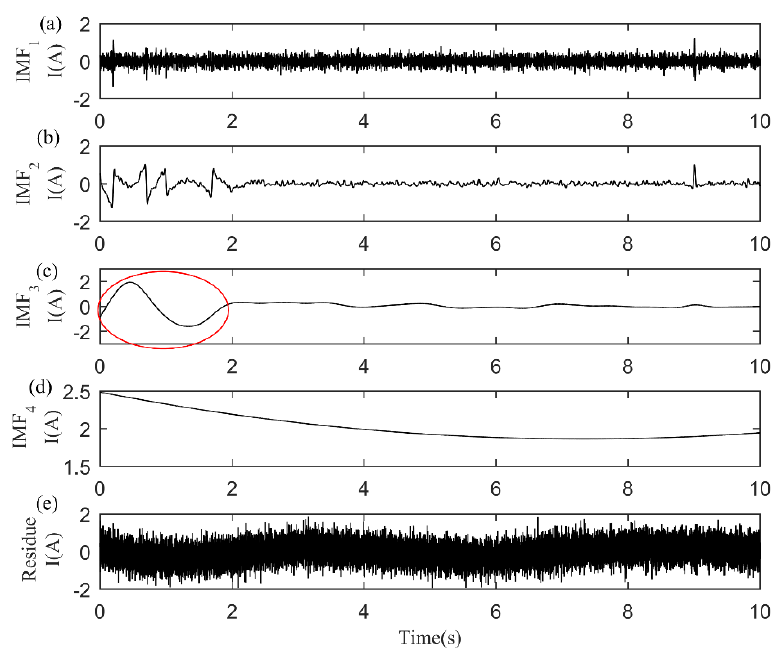
Figure 15. EEMD decomposition diagram under the noise of SNR 5. ( a ) IMF 1 component; ( b ) IMF 2 component; ( c ) IMF 3 component; ( d ) IMF 4 component; ( e ) Residue.